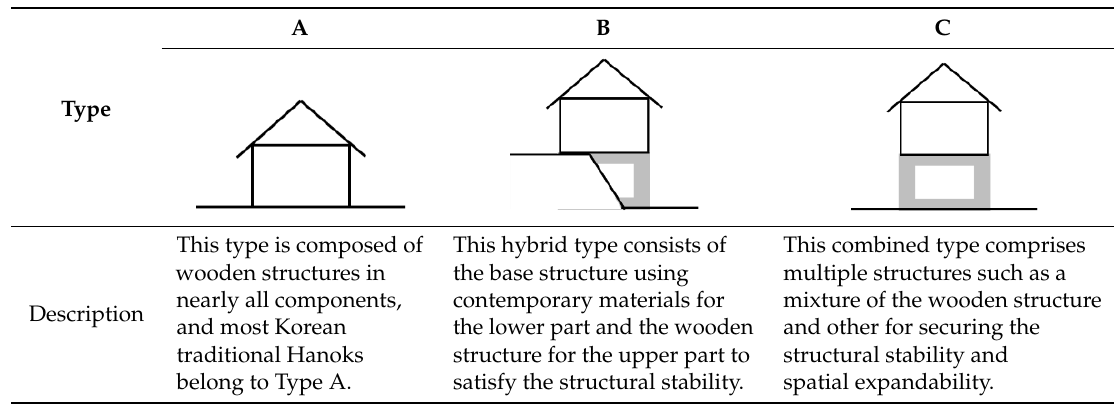
Table 1. Types of the public facility in Hanok.